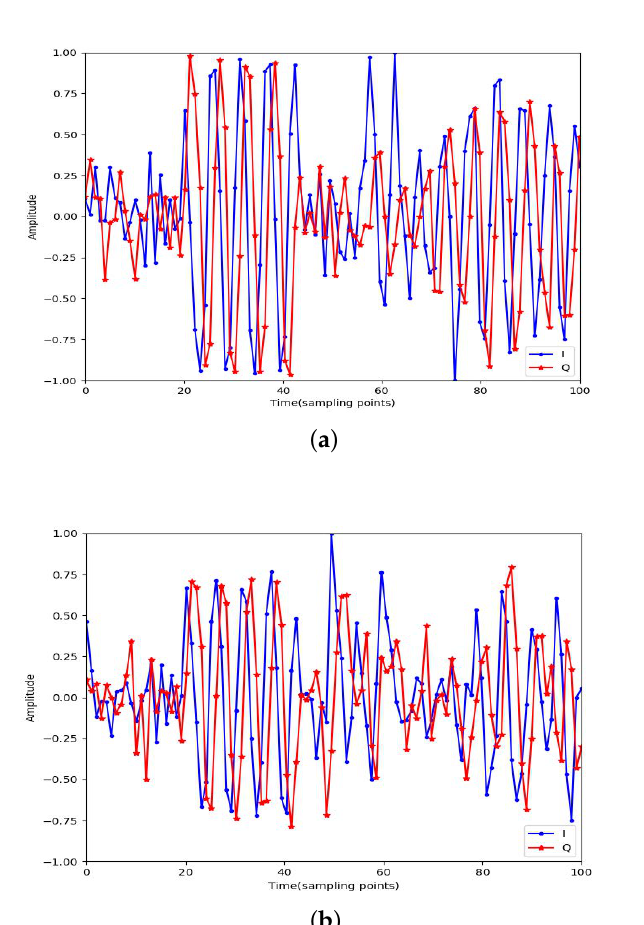
Figure 2. The signal waveform diagram. ( a , b ) represent the I/Q signals. The number of sampling points are 100, and the amplitude is scaled between 0 and 1. I component is depicted by a blue solid line with ball mark and Q component is represented by a red solid